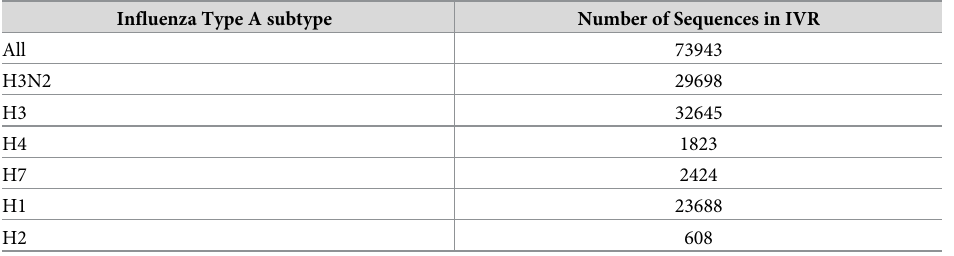
Table 2. Number of sequences within each influenza type A HA sequence